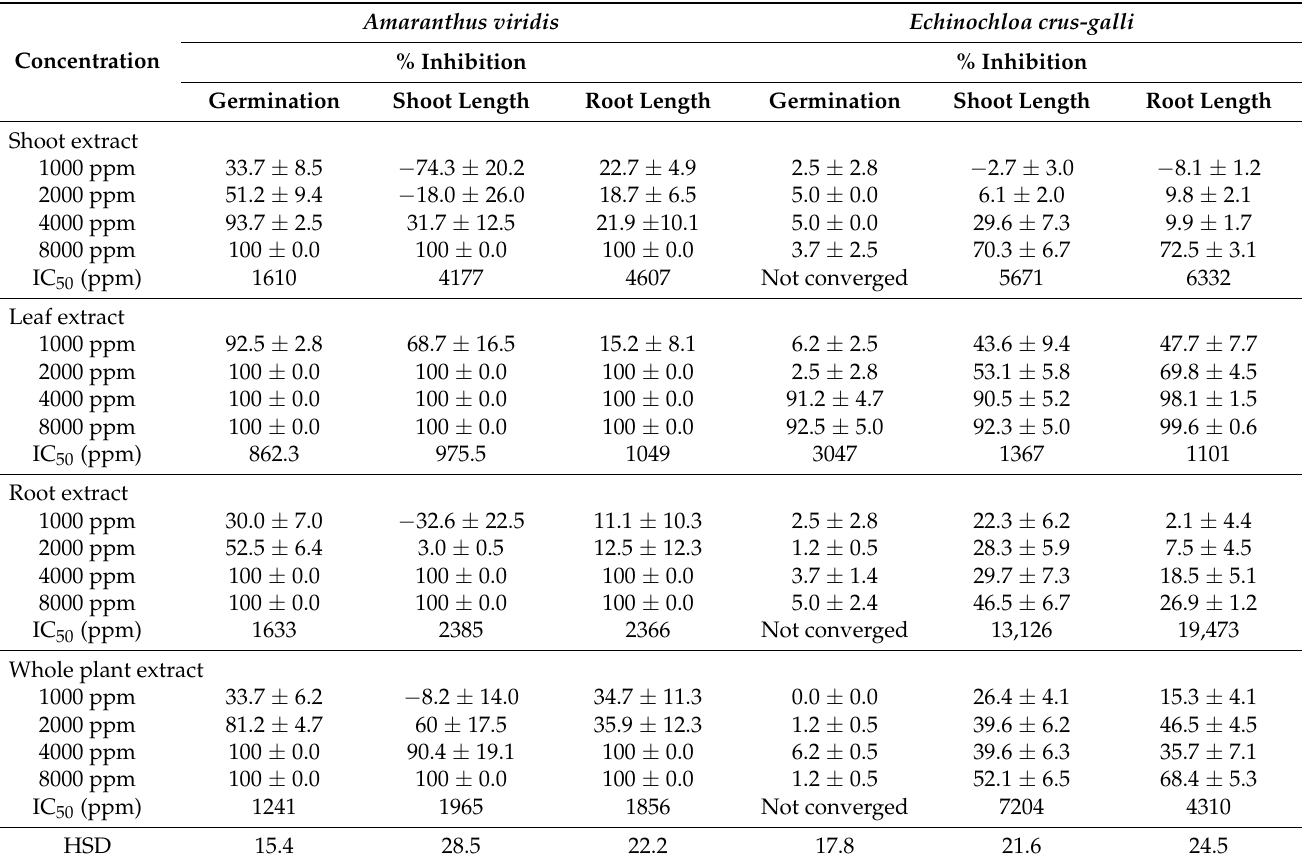
Table 1. The inhibitory effect of crude ethanol extract obtained by different parts from Chromolaena odorata on germination, shoot length, and root length of Echinochloa crus-galli and Amaranthus viridis at 7 days after experiments with Petri-dish test. Amaranthus viridis Echinochloa crus-galli Concentration % Inhibition % Inhibition Root Length Germination Shoot Length Root